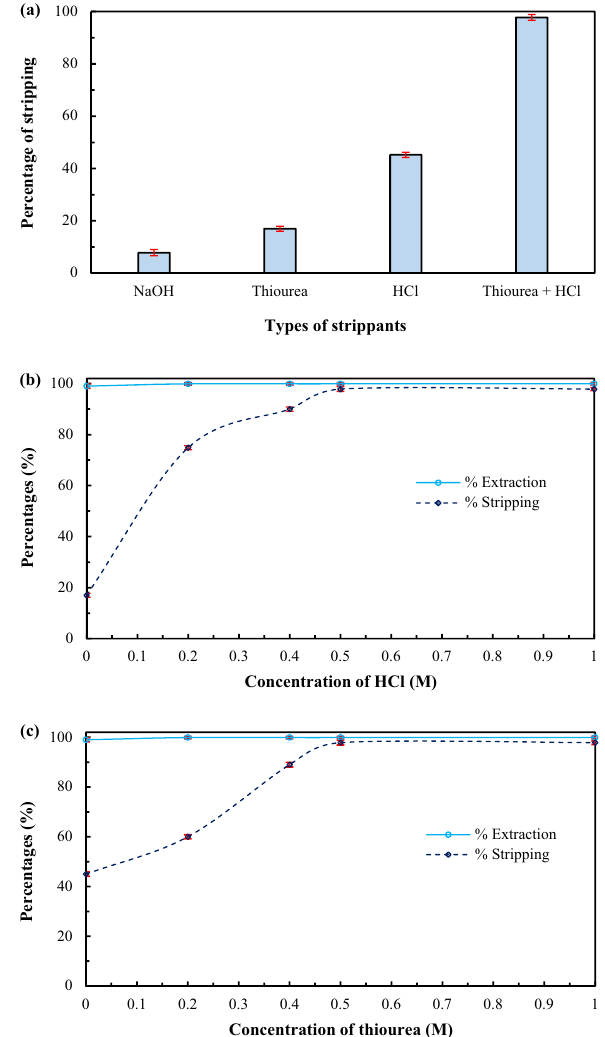
Figure 6. Percentages of extraction and stripping of arsenic ions using 0.68 M Aliquat 336 dissolved in toluene as the liquid membrane, having pH 12 of feed solution, at flow rates of feed and strippant solutions of 100 mL/ min: ( a ) types of strippant solutions (0.5 M each); standard deviation = ± 1.07. ( b ) 0.5 M thiourea mixed with various concentrations of HCl; standard deviations for %extraction = ± 0.55 and for %stripping = ± 0.80. ( c ) 0.5 M HCl mixed with various concentrations of thiourea; standard deviations for %extraction = ± 0.55 and for %stripping = ± 0.83.